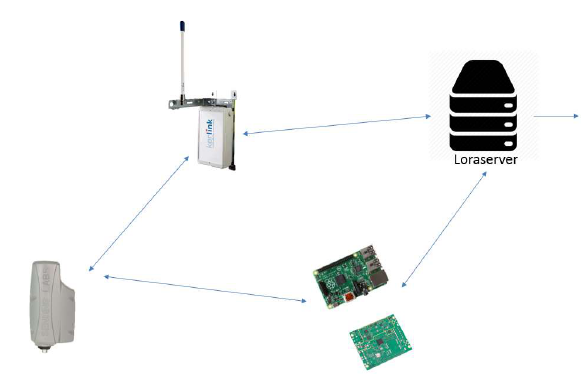
Figure 7. Temperature sensor network Architecture (Part